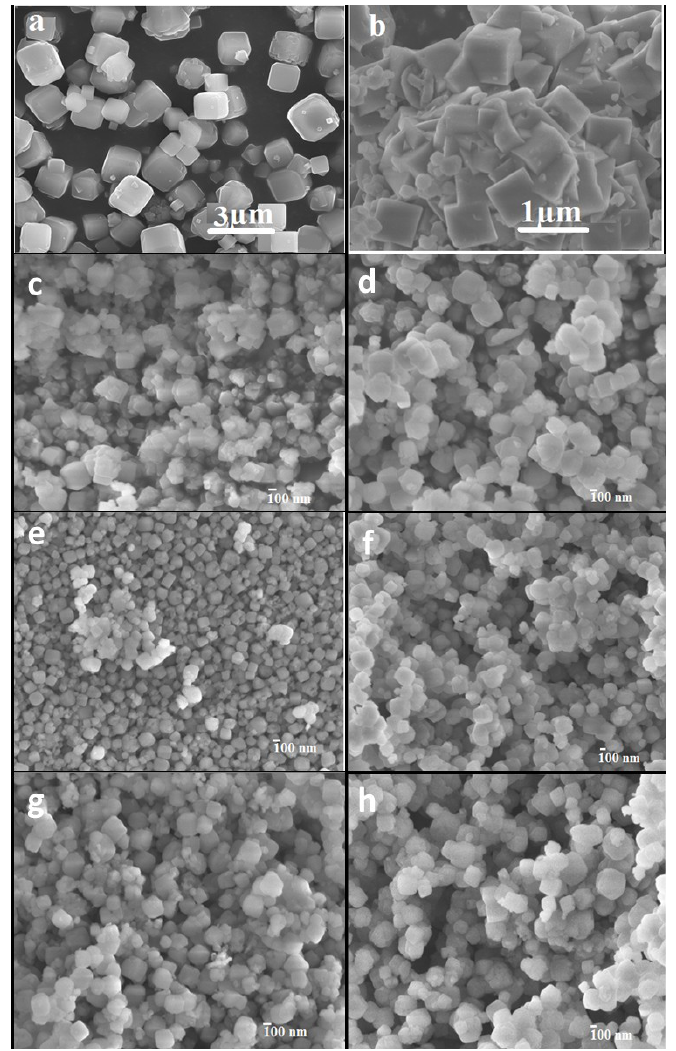
Figure 1. Scanning electron microscope (SEM) images of the nanosized zeolites synthesized with different amount of methylcellulose (MC): ( a ) conventional zeolite 4A; ( b ) Z0; ( c ) NZ010; ( d ) NZ020; ( e ) NZ040; ( f ) NZ060; ( g ) NZ080; ( h )